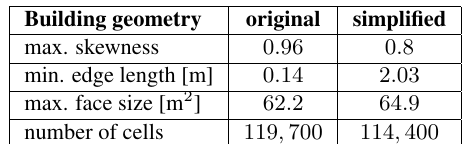
Table 2. Comparison of mesh properties for the original and the simplified building: minimal edge length, maximal face size and number of cells.